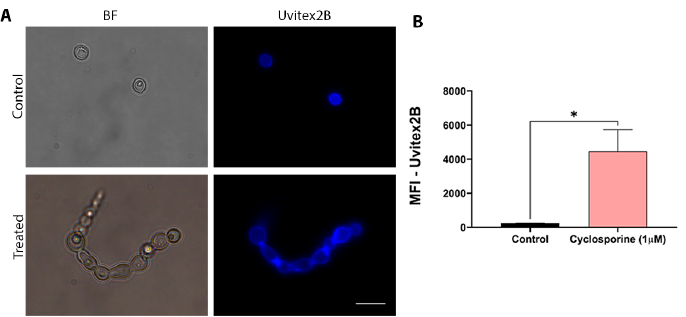
Figure 2. Effects of cyclosporine on chitin production by Cryptococcus neoformans . ( A ) Fluorescence electron microscopy of untreated and treated cells with 1 µ M cyclosporine. BF: bright field; Uvitex2B: dye used for marking chitin. Scale bar: 10 µ m. ( B ) Analysis of the mean fluorescence intensity (MFI) of untreated C. neoformans cells and those treated with 1 µ M cyclosporine and labeled with Uvitex2B, a chitin cell wall marker. Statistical significance was determined via a t -test (* p -value = 0.04).